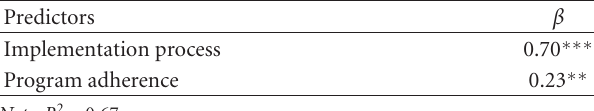
Table 5: Regression table of implementation